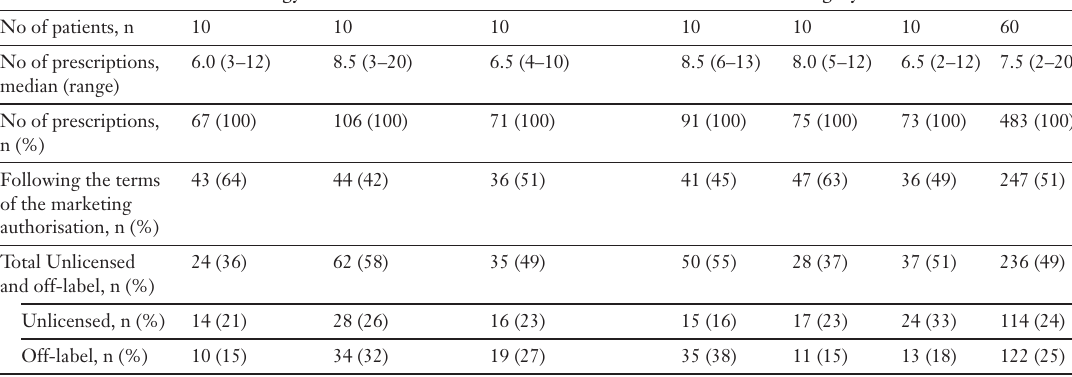
* Wards from the University Hospital CHUV; ** Ward from the Children’s Hospital of Lausanne (HEL)